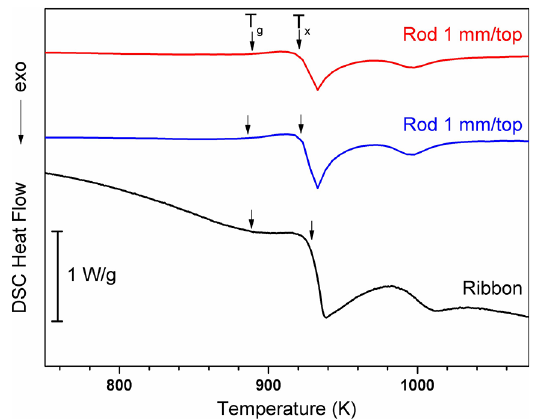
A higher amount of amorphous phase forms in samples solidified under higher cooling rates. The cooling rate applied Figure 2. DSC results of 1 mm diameter rod (top and bottom) and